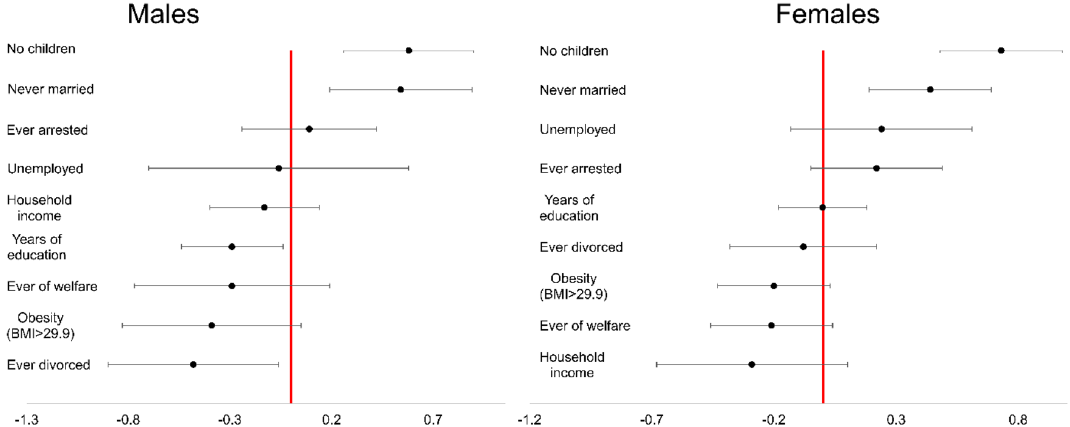
Figure 2. Estimated effect of adolescent-onset depression within males (left) and females